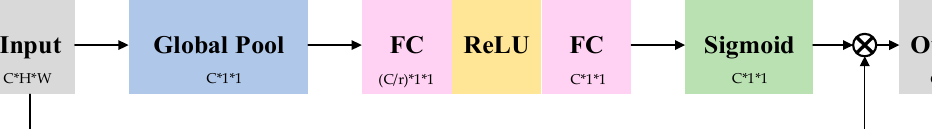
Figure 3. SENet attention structure diagram.